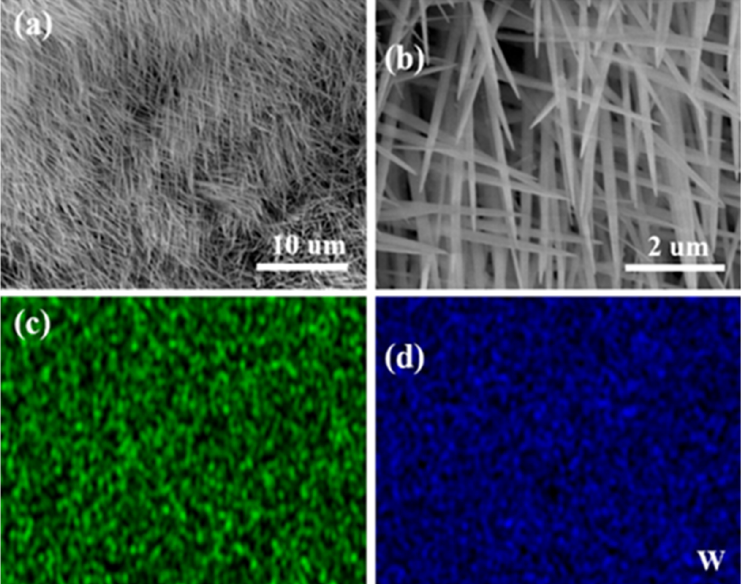
Figure 2. ( a , b ) SEM images of WO 3 nanowires at different magnifications; ( c , d ) SEM mapping images of O and W elements, respectively.